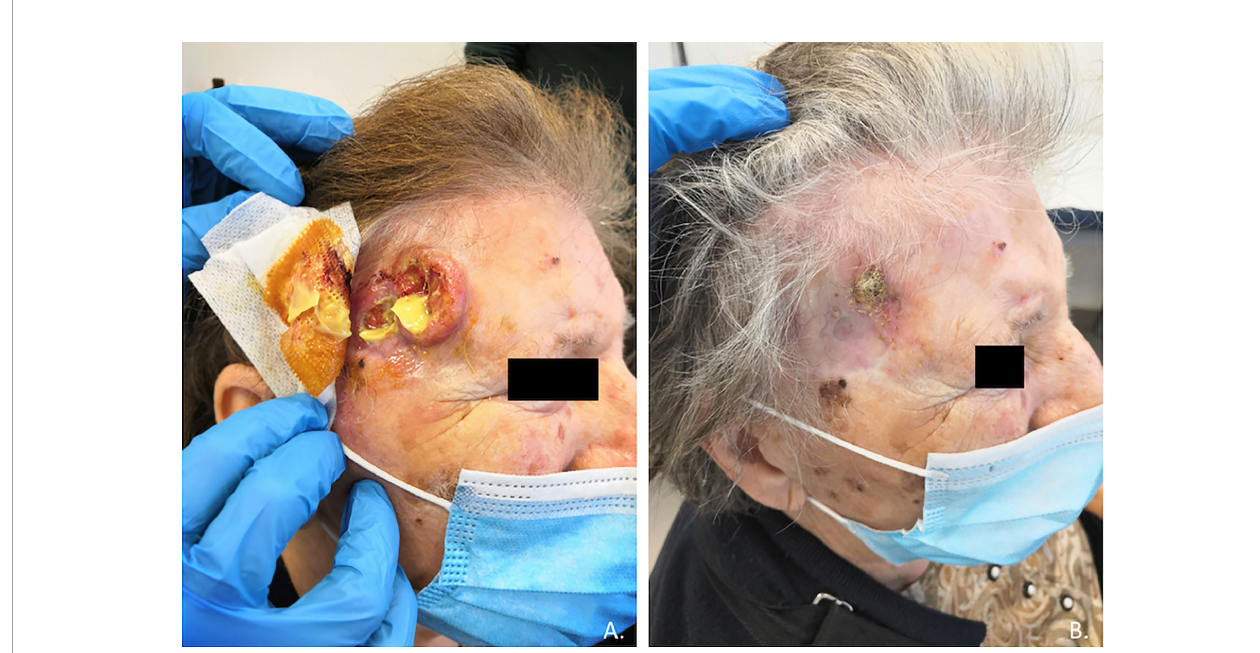
FIGURE 2 | Case report of a rapid clinical response, after only one course of therapy with cemiplimab, in an 83-year-old patient with locally advanced recurrence of cutaneous squamous carcinoma of the right temporal region (A,B)